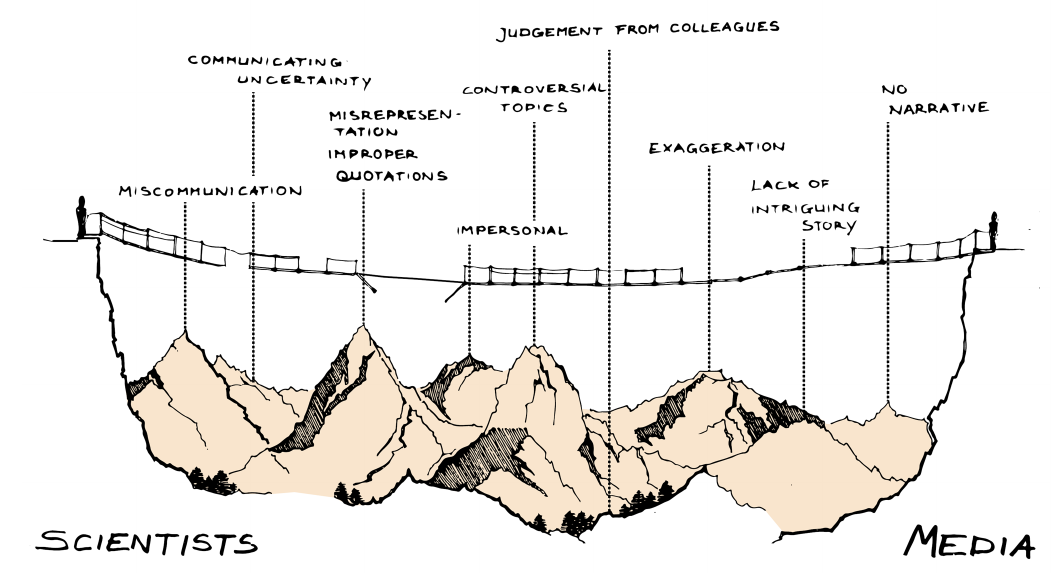
Figure 2. Challenges and fears of scientists and journalists in science communication (figure by Cher van den